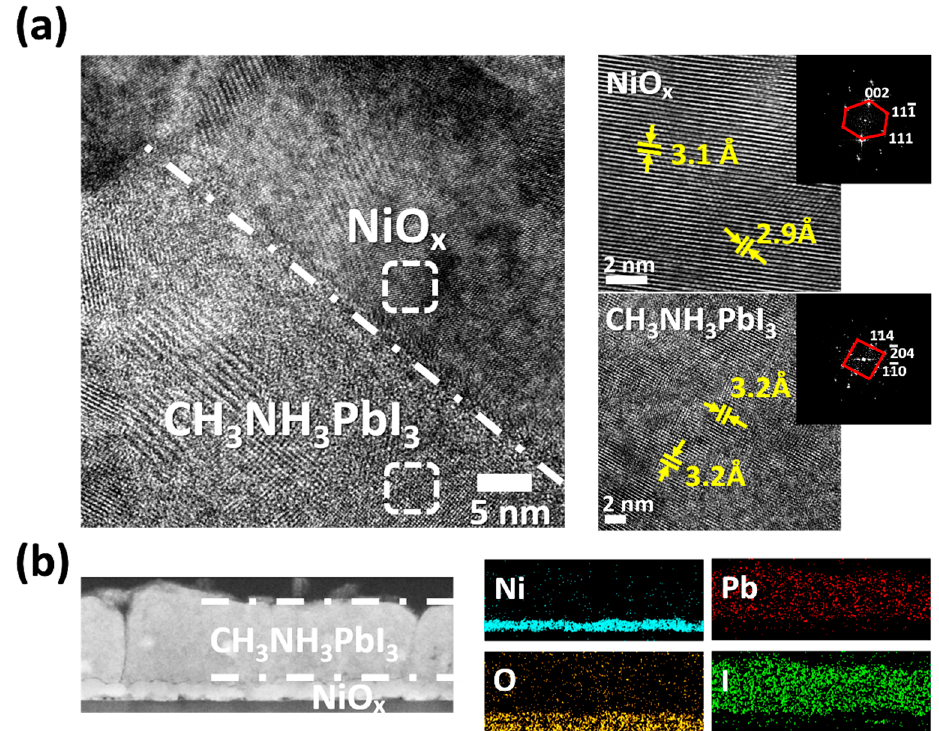
Figure 5. HRTEM image shows the crystal structure of NiO x /CH 3 NH 3 PbI 3 films: ( a ) the NiO x /CH 3 NH 3 PbI 3 films (scale bar is 5 nm). The dashed box areas of NiO x and CH 3 NH 3 PbI 3 are shown as magnified views in the right-hand side (scale bar is 2 nm). Inset are FT patterns. The zone axis of NiO x (top): [110] cub , CH 3 NH 3 PbI 3 (bottom): [221] tet . ( b ) EDS maps show the elemental distribution of Ni (blue), Pb (red), O (yellow), and I (green) of NiO x /CH 3 NH 3 PbI 3 .